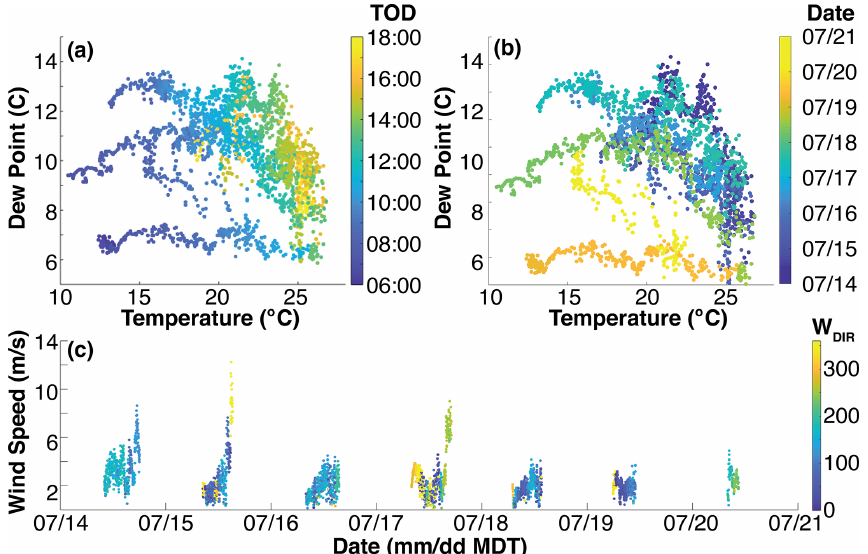
Figure 8. Panels illustrating the temporal variability of the temperature (a,b) , dew point temperature (a,b) , and wind data (c) collected by the CU MURC. Panel (a) shows diurnal variability, while (b) shows the variability by date.